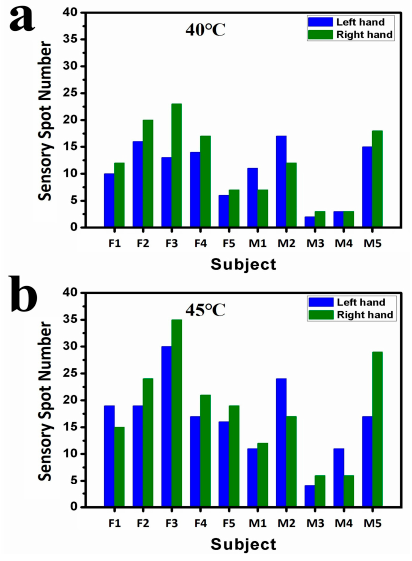
locations of sensory spots and the habits of hand use.